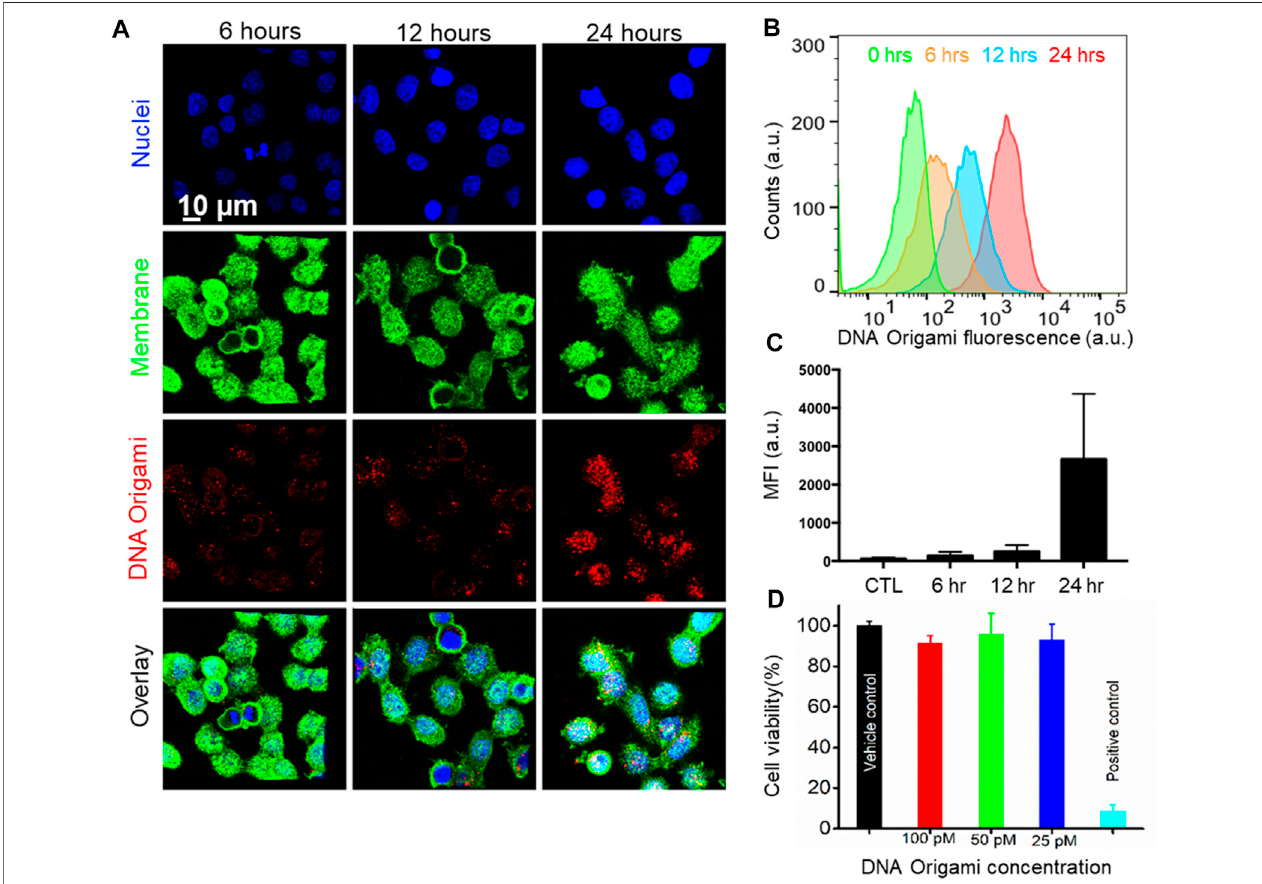
FIGURE 4 | (A) Confocal Fluorescence microscope images of time-dependent targeted DNA origami uptake. MDA-MB-468 cells were incubated with 10 pM of targetedDNAorigami structures for6, 12,and 24 hrespectively, suggesting ahigher cellular uptake withincreasingtime;Cell nucleusand membranewerestained with Hoechst ® 33342 (blue) and wheat germ agglutinin, AF488 conjugate (green), respectively. (B, C) Flow cytometry-based measurement also showed enhanced intracellular fl uorescence with increasing time. (D) WST1 Cell viability assay validated no signi fi cant toxicity up to 100 pM targeted DNA origami.